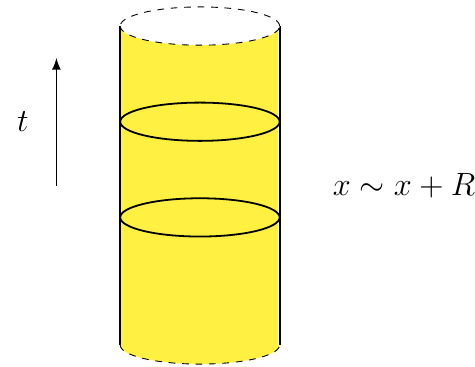
Figure 1 . The integration contour for the Wilson loop can be moved freely along the space-time